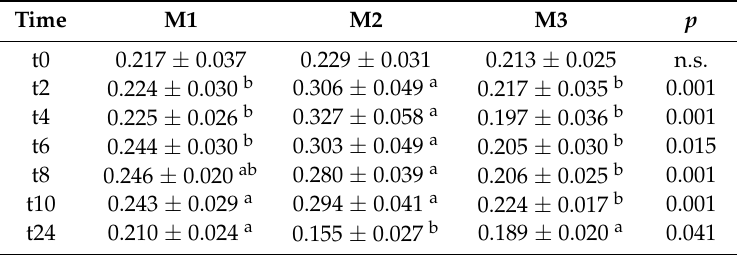
Table 3. TRP/5LNAAs ratio values (mean ± S.D.) in the three meals at the different times. M1 = Meal 1; M2 = Meal 2; M3 = Meal